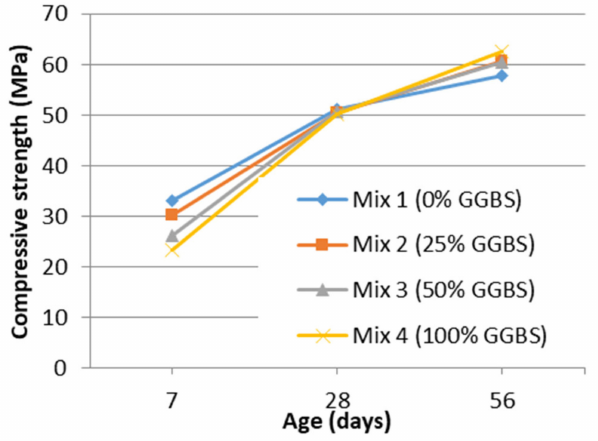
Figure 10. Compressive strength development for concretes with di ff erent addition percentages of GGBS, k = 0.6, targeted air content of 4.5% ± 0.5%, cured at 20 ◦ C.